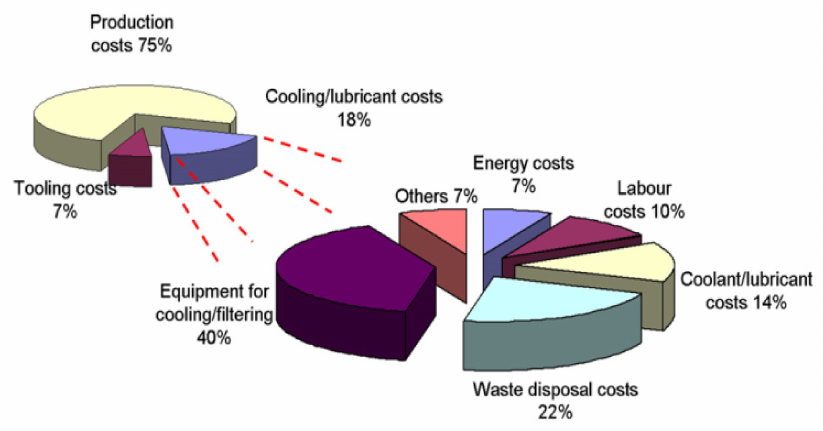
Figure 2. Pressure to change the paradigms of the manufacturing industry, reprinted with permission from ref. [30]. Copyright 2010 Elsevier Ltd.